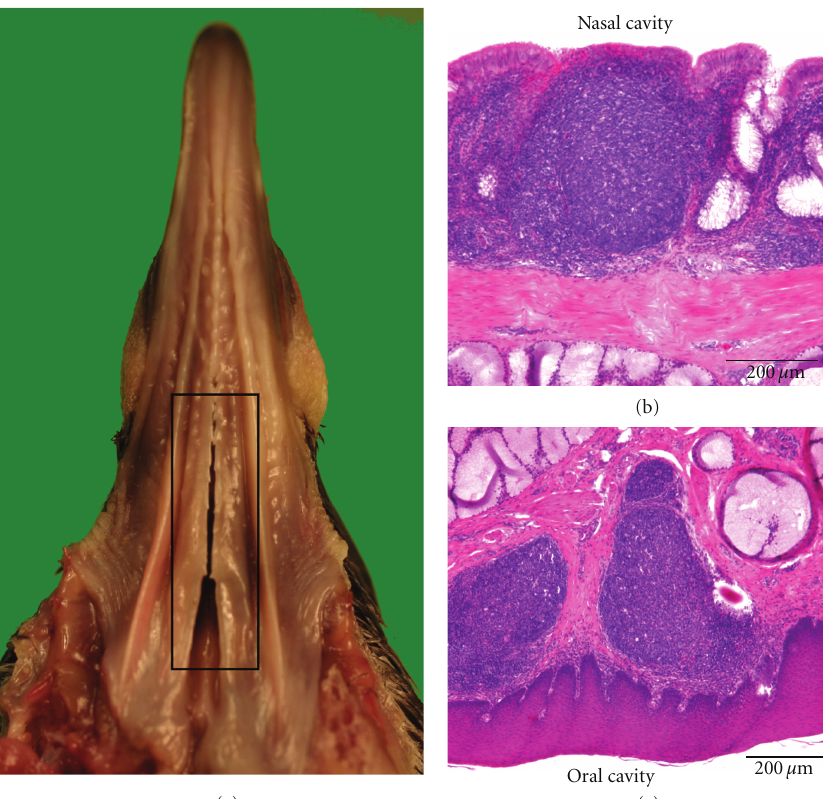
Figure 10: (a) Ventral view of the palate of a pigeon showing the location of the lymphoid tissue around the choanal and infundibular clefts (boxed area). (b) and (c) Histological sections of the palate showing organized lymphoid tissue that is present underneath the respiratory epithelium lining the nasal cavity (b) and underneath the keratinized stratified squamous epithelium lining the oral cavity